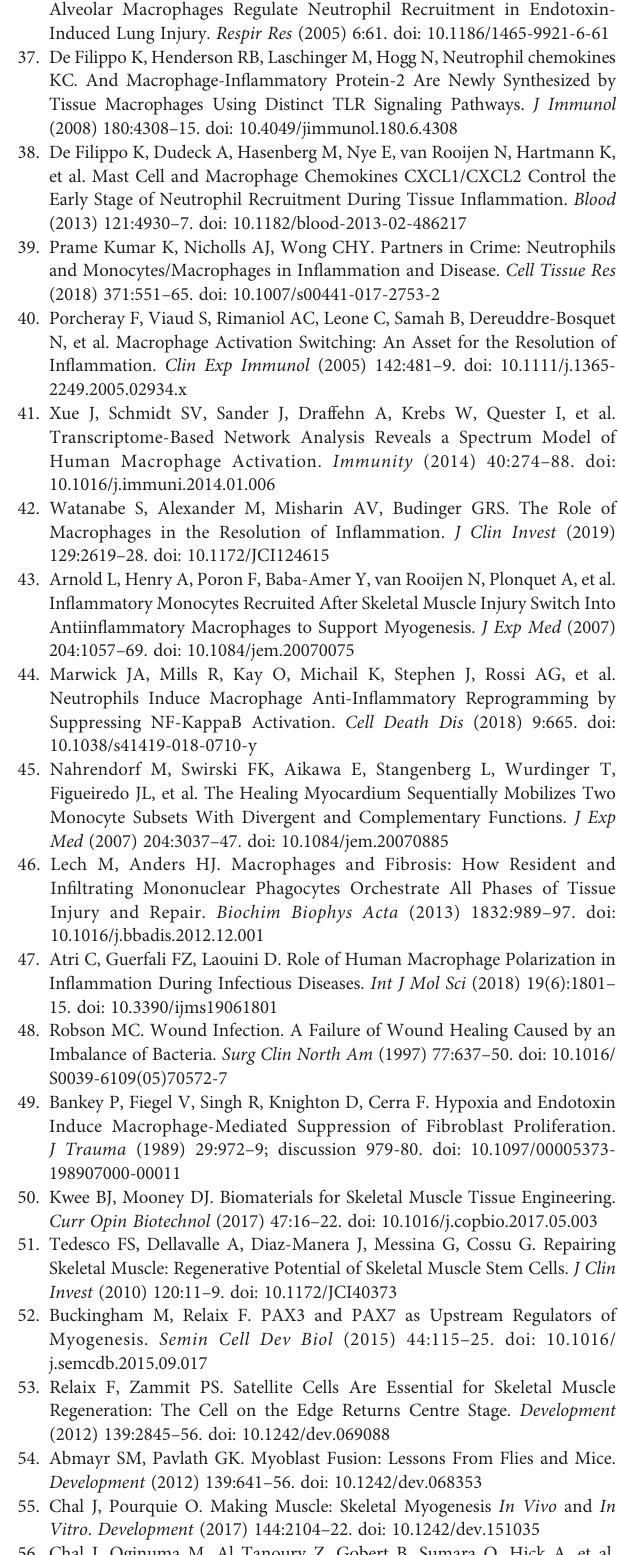
Figueiredo JL, et al. The Healing Myocardium Sequentially Mobilizes Two Monocyte Subsets With Divergent and Complementary Functions. J